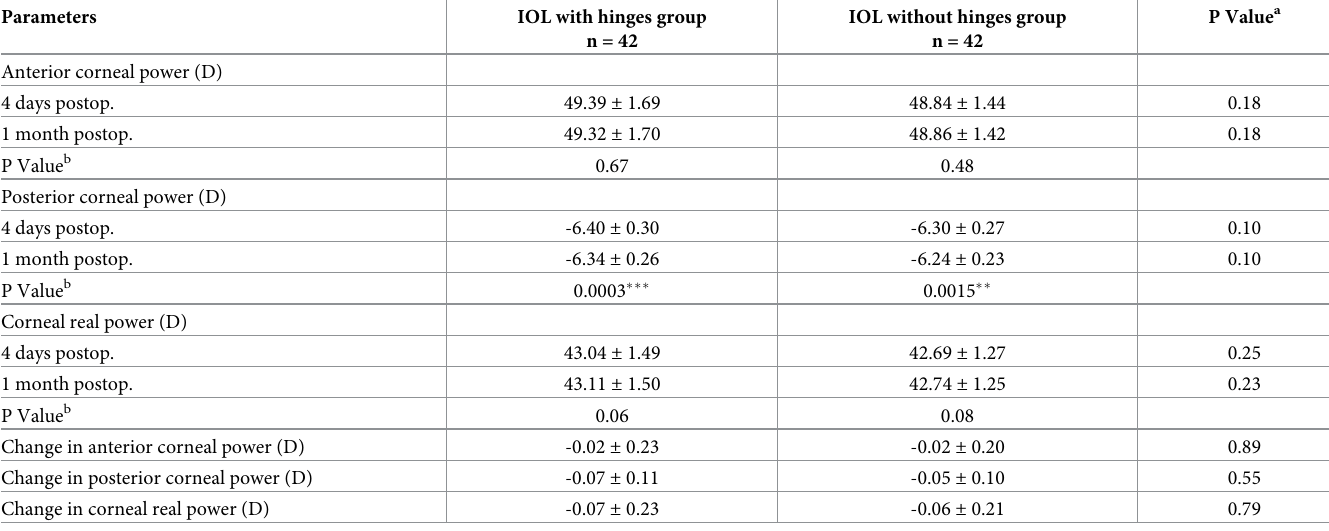
Table 3. Comparison of mean ( ± SD) anterior and posterior corneal power, change in each corneal power. Parameters